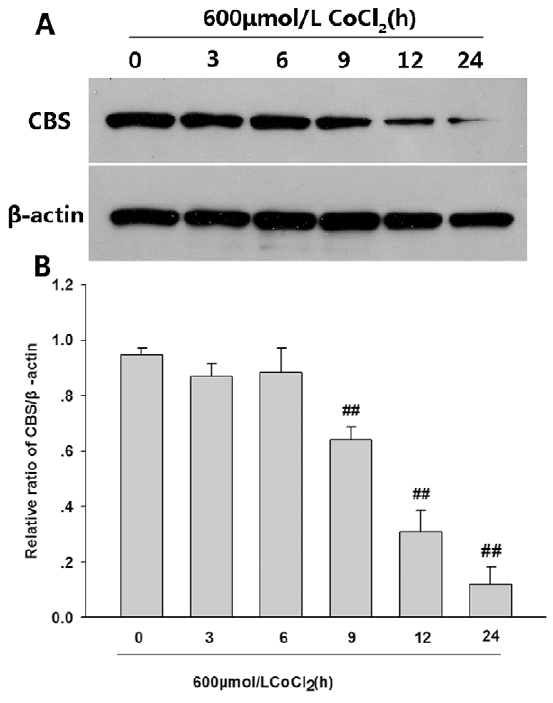
Figure 1. CoCl 2 -induced expression of HIF-1 a in PC12 cells. (A) time course for the effects of CoCl 2 on expression of HIF-1 a detected by western blot analysis; (B) Denstiometric analysis for the results in (A) with the Image J 1.41o software. Data were shown as the mean 6 SE (n=3). ## P , 0.01 compared with control group (0h).